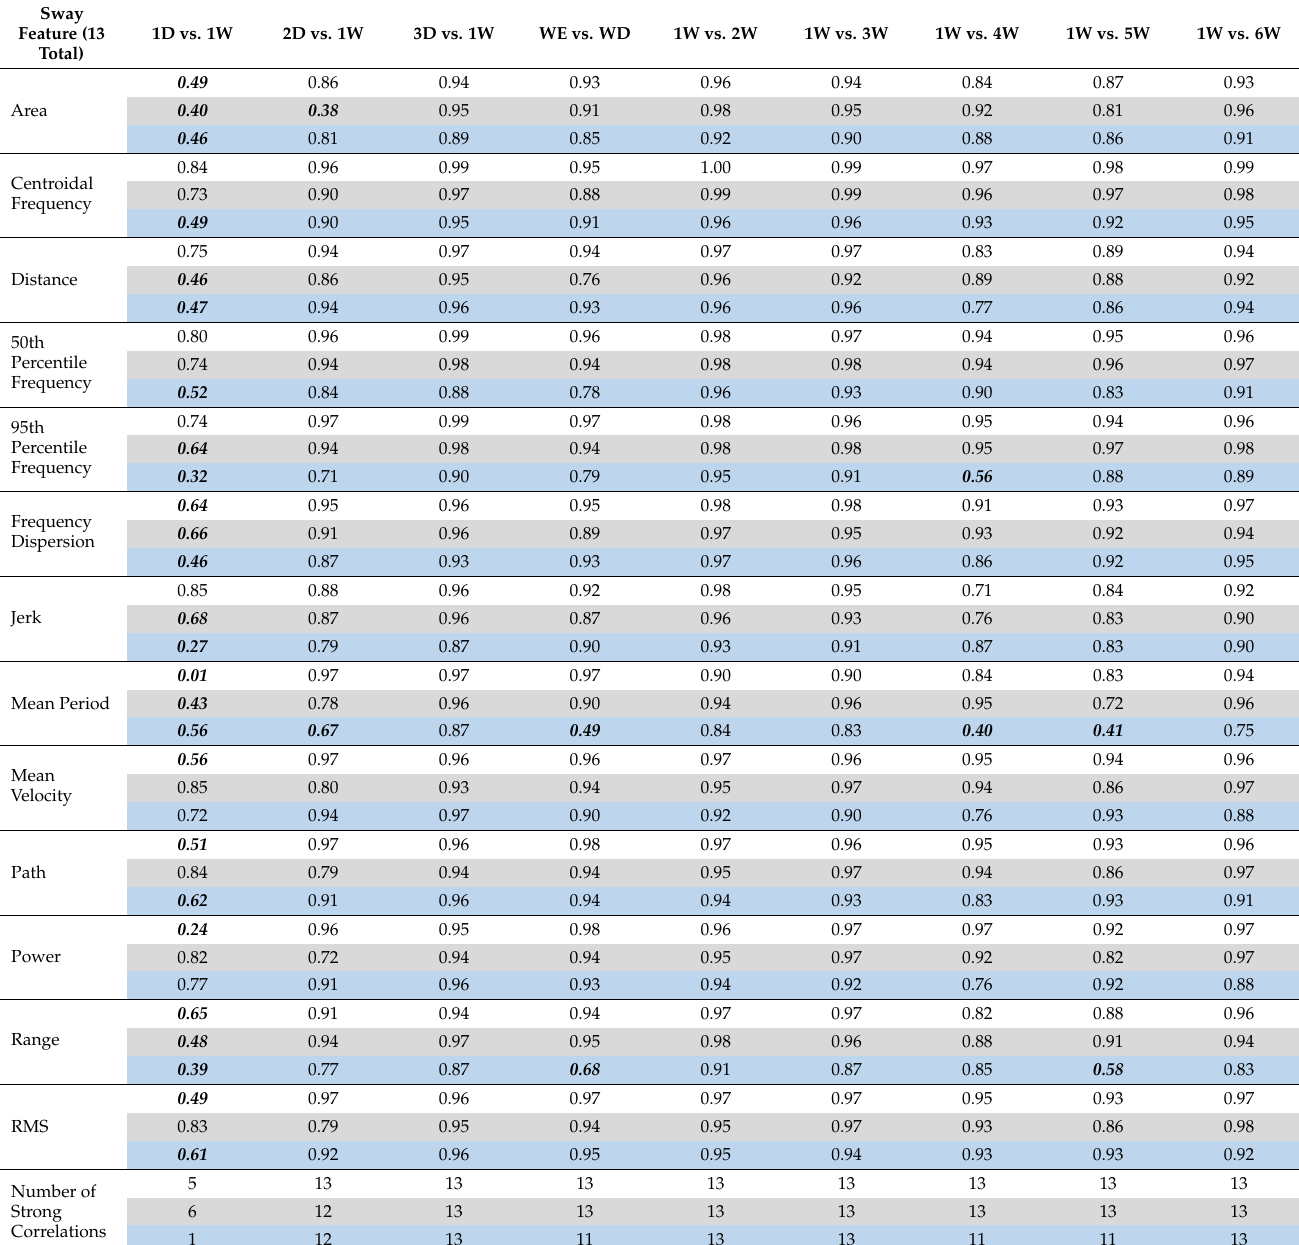
Intra-class correlation of sway features between differing timeframes in PwMS. Non-shaded cells are the correla- tion between feature medians, grey shaded cells are the correlation between feature 95th percentiles, and blue shaded cells are the correlation between feature coefficient of variation (CV) values. Timeframes are abbreviated as follows: 1D = 1 Day, 2D = 2 Days, 1W = 1 Week, WE = Weekend, WD = Weekday, etc. Correlations are considered strong if the reported value is greater than or equal to 0.70, values below are bolded and